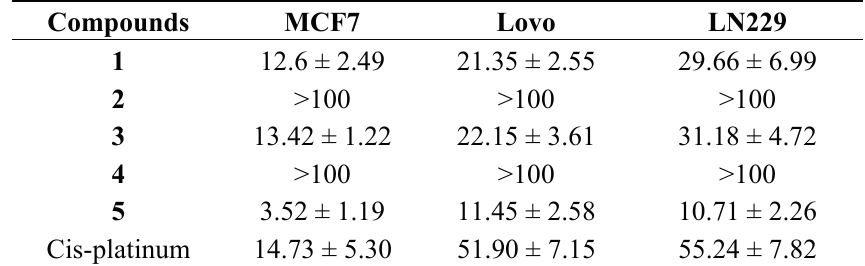
Table 2. In vitro cytotoxicity of Compounds 1 – 5 against MCF7, Lovo and LN229 cells (IC 50 , μ M) for 72 h.